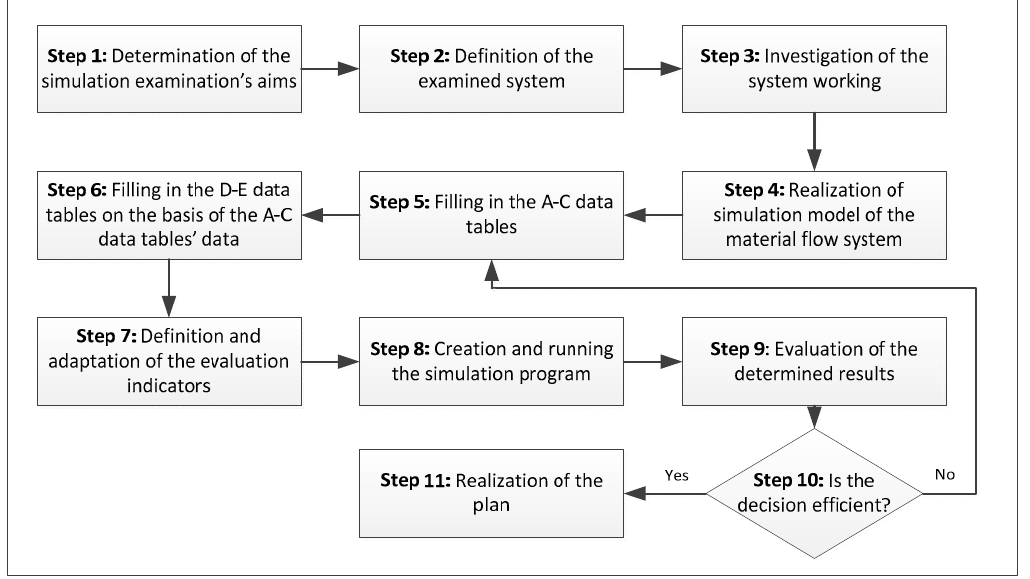
Figure 1. Steps of the simulation investigation method of intermittent manufacturing systems.